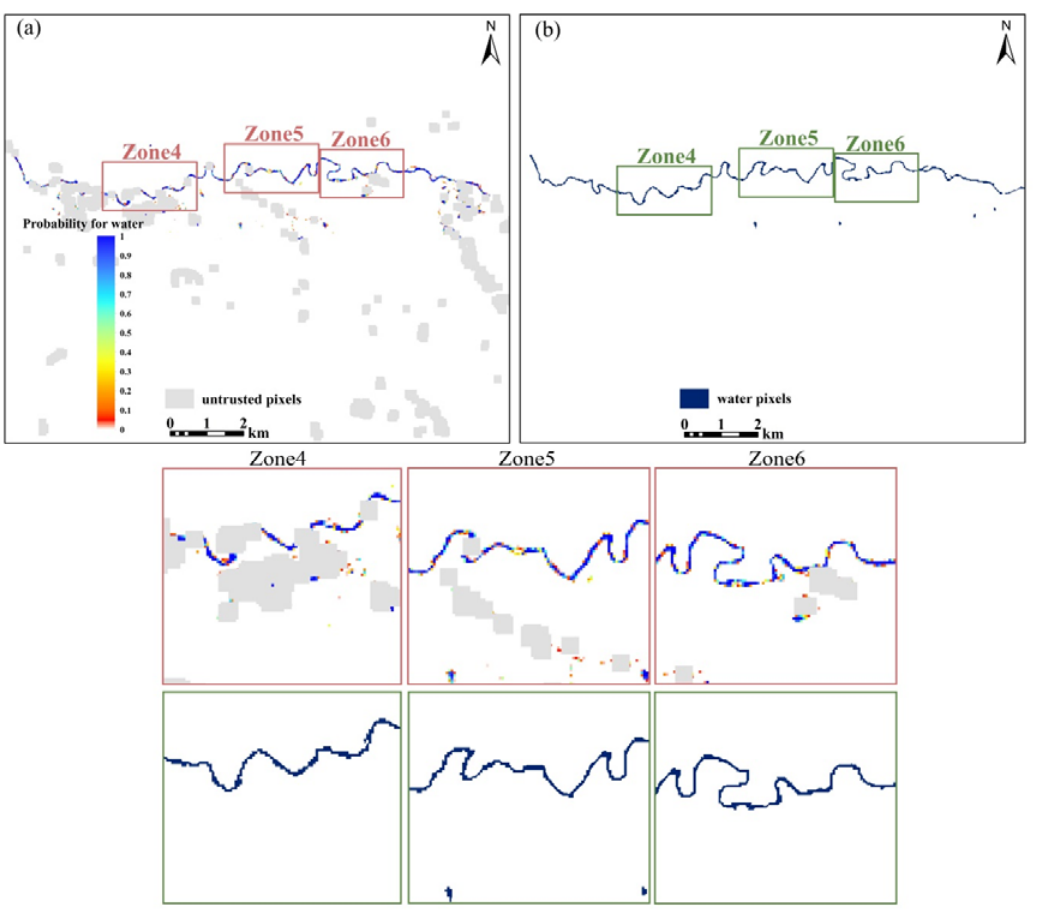
Figure 5. ( a ) The posterior probability map in the Shuangtabu reach of the Shule River, and ( b ) the referencing water map derived by visually interpreting the Sentinel ‐ 2 image.